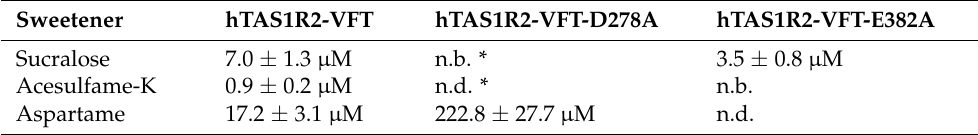
Figure 6. Titration curves of hTAS1R2-VFT-D382A (red triangles) and hTAS1R2-VFT (black circles) with sucralose ( A ) and acesulfame K ( B ). Circles and triangles show experimental data, while the solid lines are the computed binding curves. Wild-type receptor dose–responses are the same as for Figure 4. Data points correspond to the means ± SEMs of at least n = 12 independent replicates of at least three independently refolded protein samples. Table 2. Apparent K d values measured by intrinsic tryptophan fluorescence for hTAS1R2-VFT and mutants D278A and E382A.